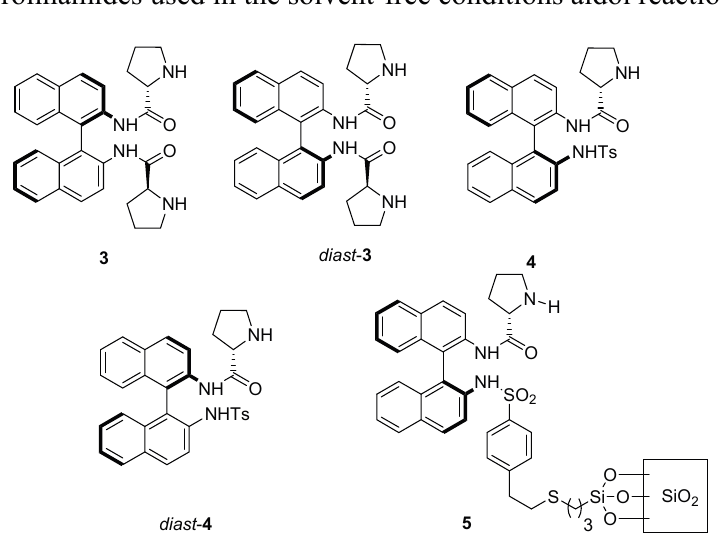
Figure 2. BINAM-prolinamides used under solvent-free conditions for the aldol